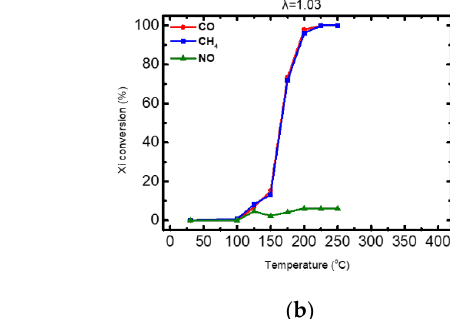
Table 7. T 50 , T 90 , T 99 and total efficiency of Prometheus monolithic catalyst for the abatement of the